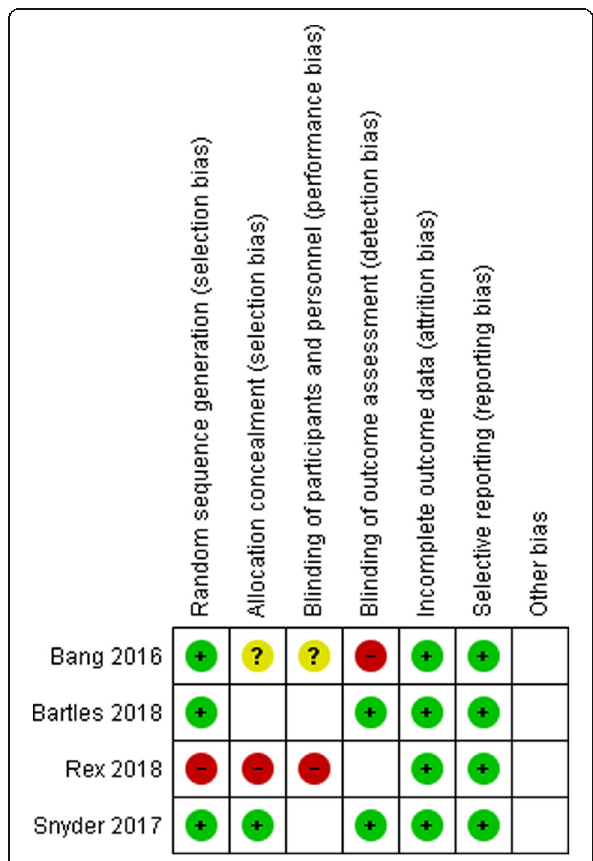
Fig. 2 Risk of bias for selected studies